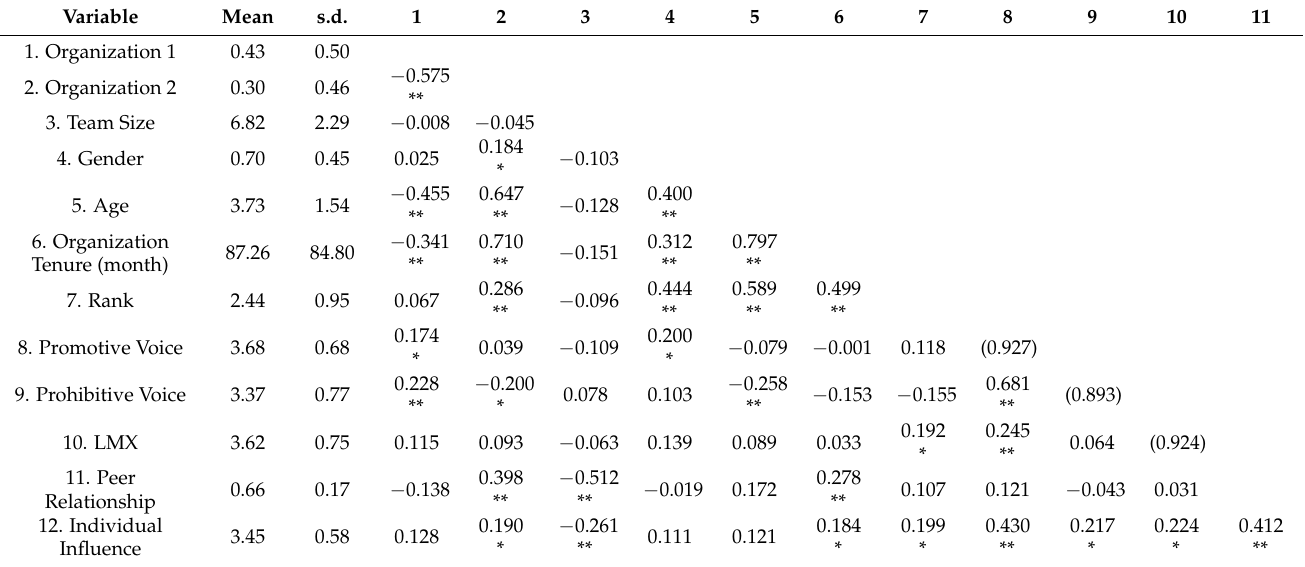
Table 3. Means, Standard Deviations, and